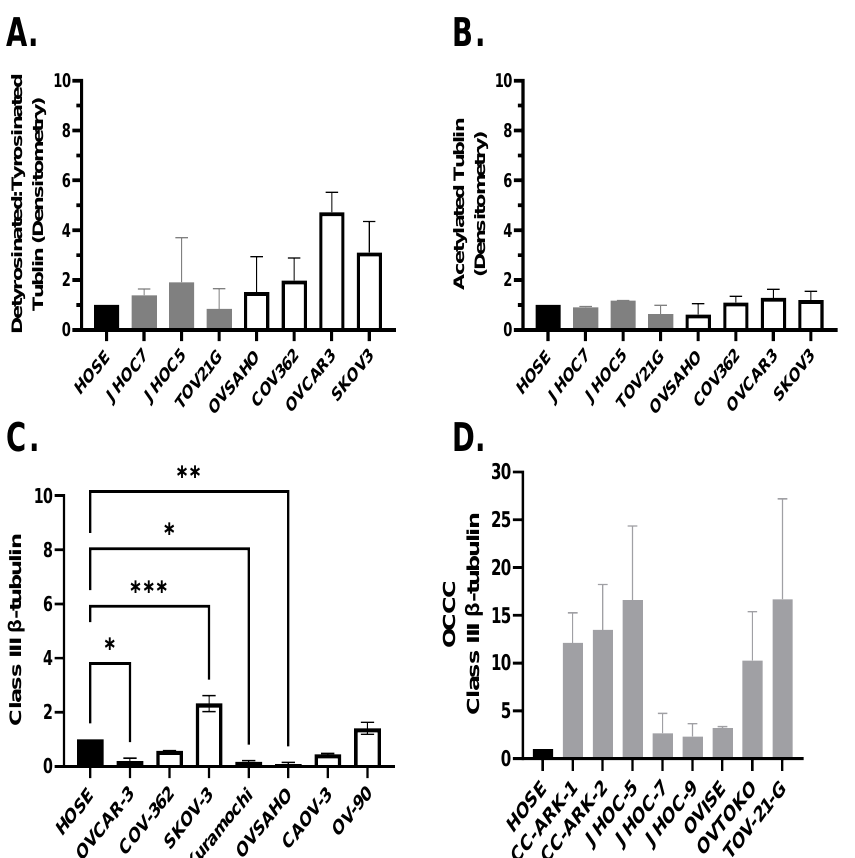
Figure 3. Western blot analysis of human ovarian surface epithelium (HOSE) (black bar), ovarian clear cell carcinoma (OCCC, gray bars), and ovarian serous carcinoma (OSC, white bars) cell lines. ( a ) Ovarian cancers exhibit more post-translational modifications of tubulin relative to HOSE with a trend showing that OSC cell lines (white) produce more McTNs with higher detyrosinated tubulin levels compared to OCCC (grey) ( p = 0.29). ( b ) Acetylated tubulin expression is similar across HOSE, OSC, and OCCC ( p = 0.61). Class III ß-tubulin is overexpressed in few OSC (1/7, white bars) ( c ) and most OCCC (5/8, grey bars) ( d ). Densitometry is shown. Data are shown in duplicate. Bars represent mean and standard error of the mean. Western blot images are provided in Supplementary material. One-way ANOVA analysis with a Dunnett post hoc analysis was performed for each data set. There was a significant difference between class III ß-tubulin expression in HOSE vs. OSC cell lines OVCAR-3, SKOV-3, Kuramochi, and OVSAHO; which did not reach significance in OCCC. * p < 0.03; ** p < 0.002; *** p <